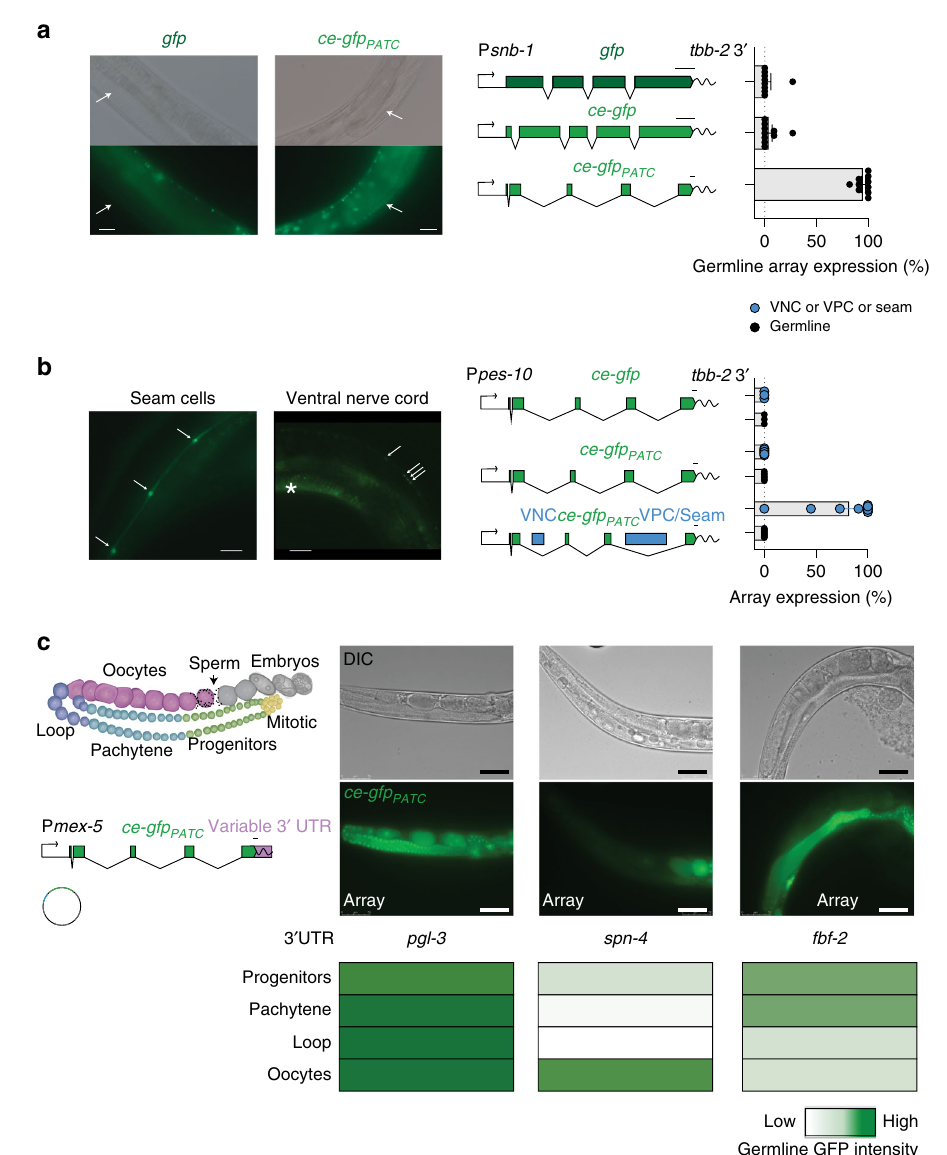
Fig. 6 PATC-rich fl uorescent proteins are not ectopically expressed. a Images of GFP expression from simple extrachromosomal arrays with transgenes expressing gfp ( “ Fire lab GFP ” ) and ce-gfp (codon-optimized GFP) under control of the synaptobrevin ( snb-1 ) promoter. The white arrowhead indicates germ cells. n = 9, 10, and 10 biologically independent transgenic lines (from top to bottom). b Test of enhancer activity from PATCs. Images of GFP expression in animals from arrays carrying a minimal pes-10 promoter fused to ce-gfp s with 900 bp introns with no PATCs (top), 900bp introns with PATCs (middle), or 900 bp introns with PATCs and enhancers (blue rectangles) for the ventral cord neurons (VCNs) or seam cell + ventral precursor cells (VPCs) 63 . Images show GFP expression in seam cells (left) and ventral cord neurons (right) indicated by white arrows. * indicates the non-speci fi c gut- granule fl uorescence. n = 3, 7, and 11 biologically independent transgenic lines (from top to bottom). c 3 ′ -UTR control of stage-speci fi c germline expression. P mex-5 :: ce-gfp PATC transgenes were expressed from arrays with several different 3 ′ -UTRs that are known to mediate stage-speci fi c germline expression 38 . The relative fl uorescence intensities are indicated in heat-maps below representative images of transgenic animals. n = 6 biologically independent transgenic lines for all 3 ′ -UTRs. Transgene scale bars = 100 nucleotides. gfp = GFP(S65C) from Fire lab vector kit (A. Fire, unpublished reagents). ce-GFP = codon-optimized GFP 44 with piRNA homology removed 45 . Fluorescence was quanti fi ed from transgenic animals carrying simple extrachromosomal arrays imaged with a ×40 or ×63 oil objective at 25 °C. Image scale bars = 50 microns. Each datapoint indicates one independent measurement of fl uorescence scored from 11 animals from an independent transgenic line. Bars indicate the mean, and error bars indicate the SEM. Source data are available in the Source Data fi 3 ′ -UTRs regulate stage-speci fi c expression within the germ- line 38 , and we tested if optimized fl uorescent proteins capture this regulation. We generated P mex-5 :: ce - gfp PATC transgenes with two 3 ′ -UTRs known to regulate gene expression in speci fi c regions of the germline ( fbf-2 and spn-4 3 ′ -UTRs), and one 3 ′ -UTR that permits ubiquitous expression in all germ cells ( pgl-3 3 ′ -UTR) 38 .